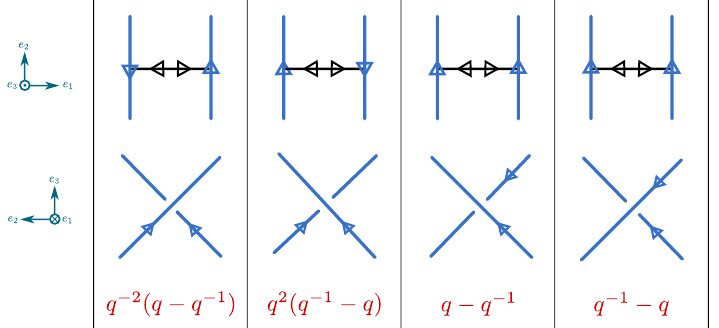
Figure 17 . The first part of exchange factors contributing to the weight α ( e L ) . We show the standard projection on top and the ij -leaf space projection